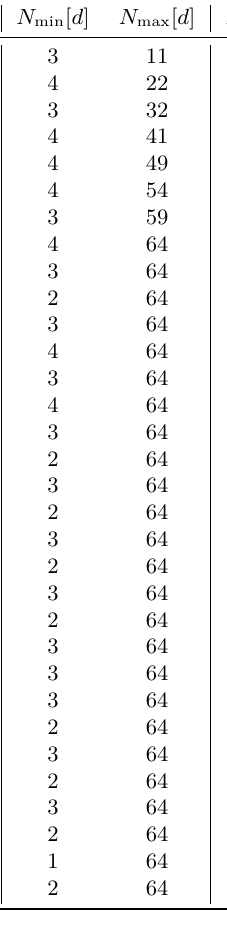
Table 1: Activity pattern of Ascon ’s linear